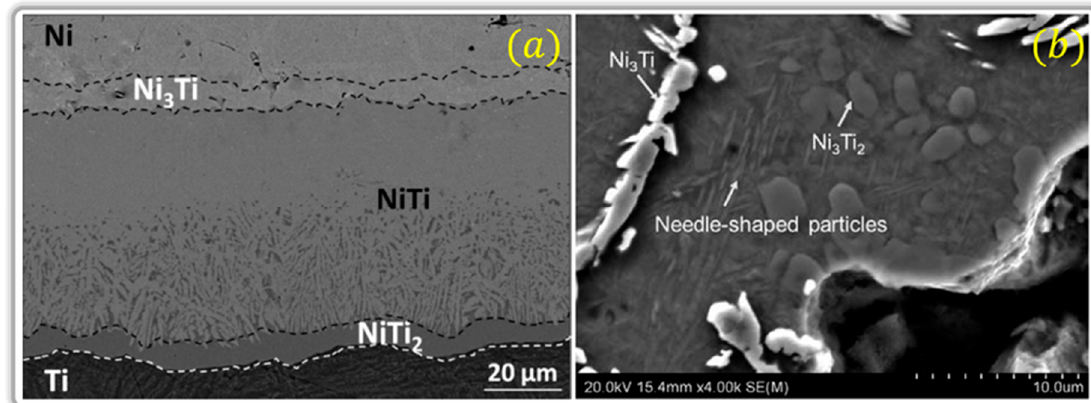
Figure 8. ( a ) The microstructure of interdiffusion zone in NiTi binary diffusion couple after annealing at 900 °C for 100 h. Adapted with permission from [71], Walter de Gruyter GmbH, Berlin/Boston, 2018. ( b ) SEM image of as-sintered samples prepared under processing conditions (pressing pressure: 400.0 MPa, sintering final temperature: 1050 °C, from ambient to 700 °C at heating rate 10 °C min − 1 , 700–900 °C at heating rate 2 °C min − 1 , 900–1050 °C at heating rate 10 °C min − 1 , sintering holding time: 4 h). Adapted with permission from [74], Elsevier, 2018.